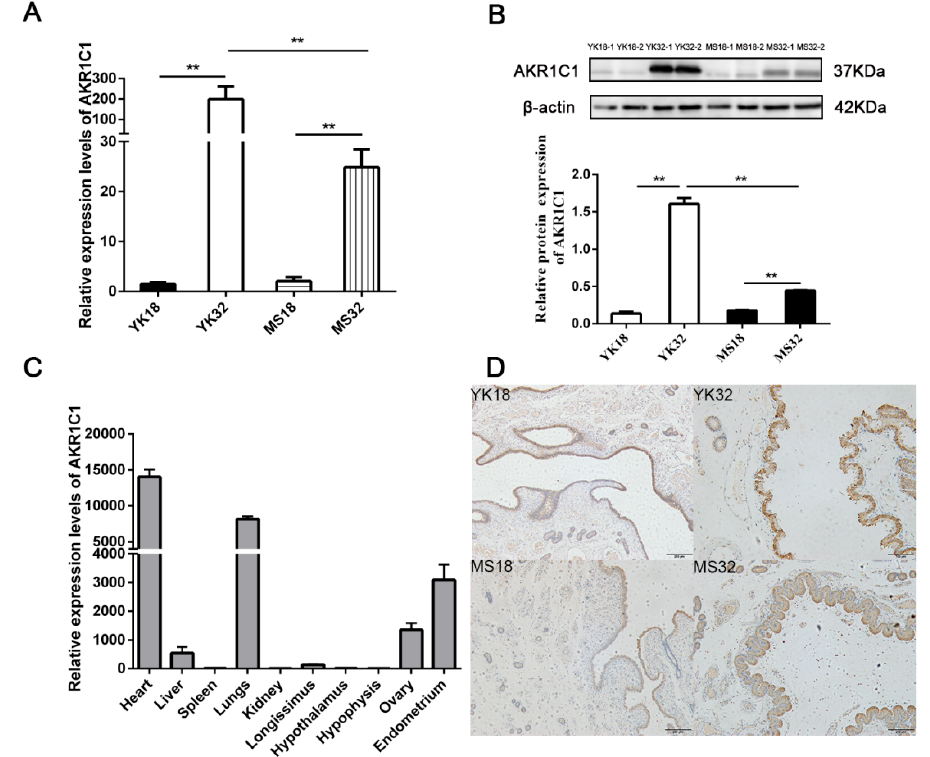
Figure 2. Feature identification of AKR1C1 . ( A ) RNA expression profile of AKR1C1 in the endometrium from Meishan and Yorkshire pigs on days 18 and 32 of pregnancy by qRT-PCR. ** represents p < 0.01. ( B ) Protein expression profile of AKR1C1 in the endometrium from Meishan and Yorkshire pigs on days 18 and 32 of pregnancy by Western blot. Down diagram: quantification of Western blot results, ** represents p < 0.01. ( C ) Expression profile of AKR1C1 by qRT-PCR in di ff erent tissues. ( D ) Immunohistochemistry result of AKR1C1 in the endometrium.